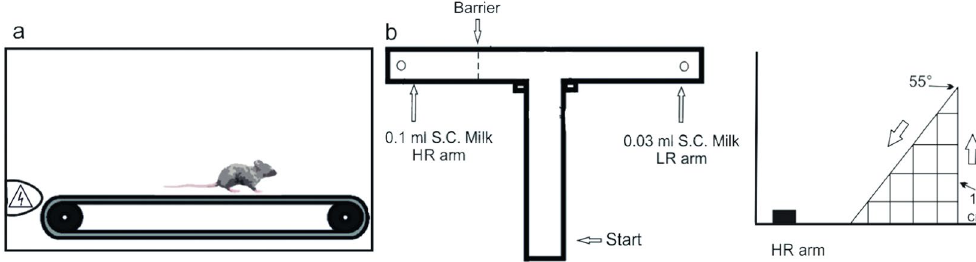
Figure 1. Experimental apparatus. ( a ) Treadmill schematic side view used throughout the running period of the study. The humidity and temperature of treadmill chamber were constant during each session. ( b ) T-maze schematic top view, mice were placed in the start arms and allowed to choose between the two arm goals. To obtain 0.1 ml of sweetened condensed milk, the animals could climb over a wire mesh barrier (HR arm); otherwise, mice could choose the low reward arm (reward = 0.03 ml). In experiment 4, a second barrier was also placed in the LR